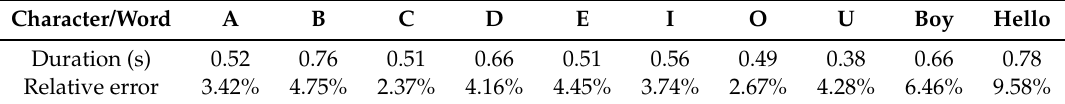
Figure 8. The auditory radar-detected time-varying vocal fold vibration frequency of the English letter and word ( a ) “a” and ( b ) “boy”, respectively. The “ × ” symbols represent the acoustic fundamental frequency values. Table 3. The relative errors of fundamental frequency of the tested English characters and